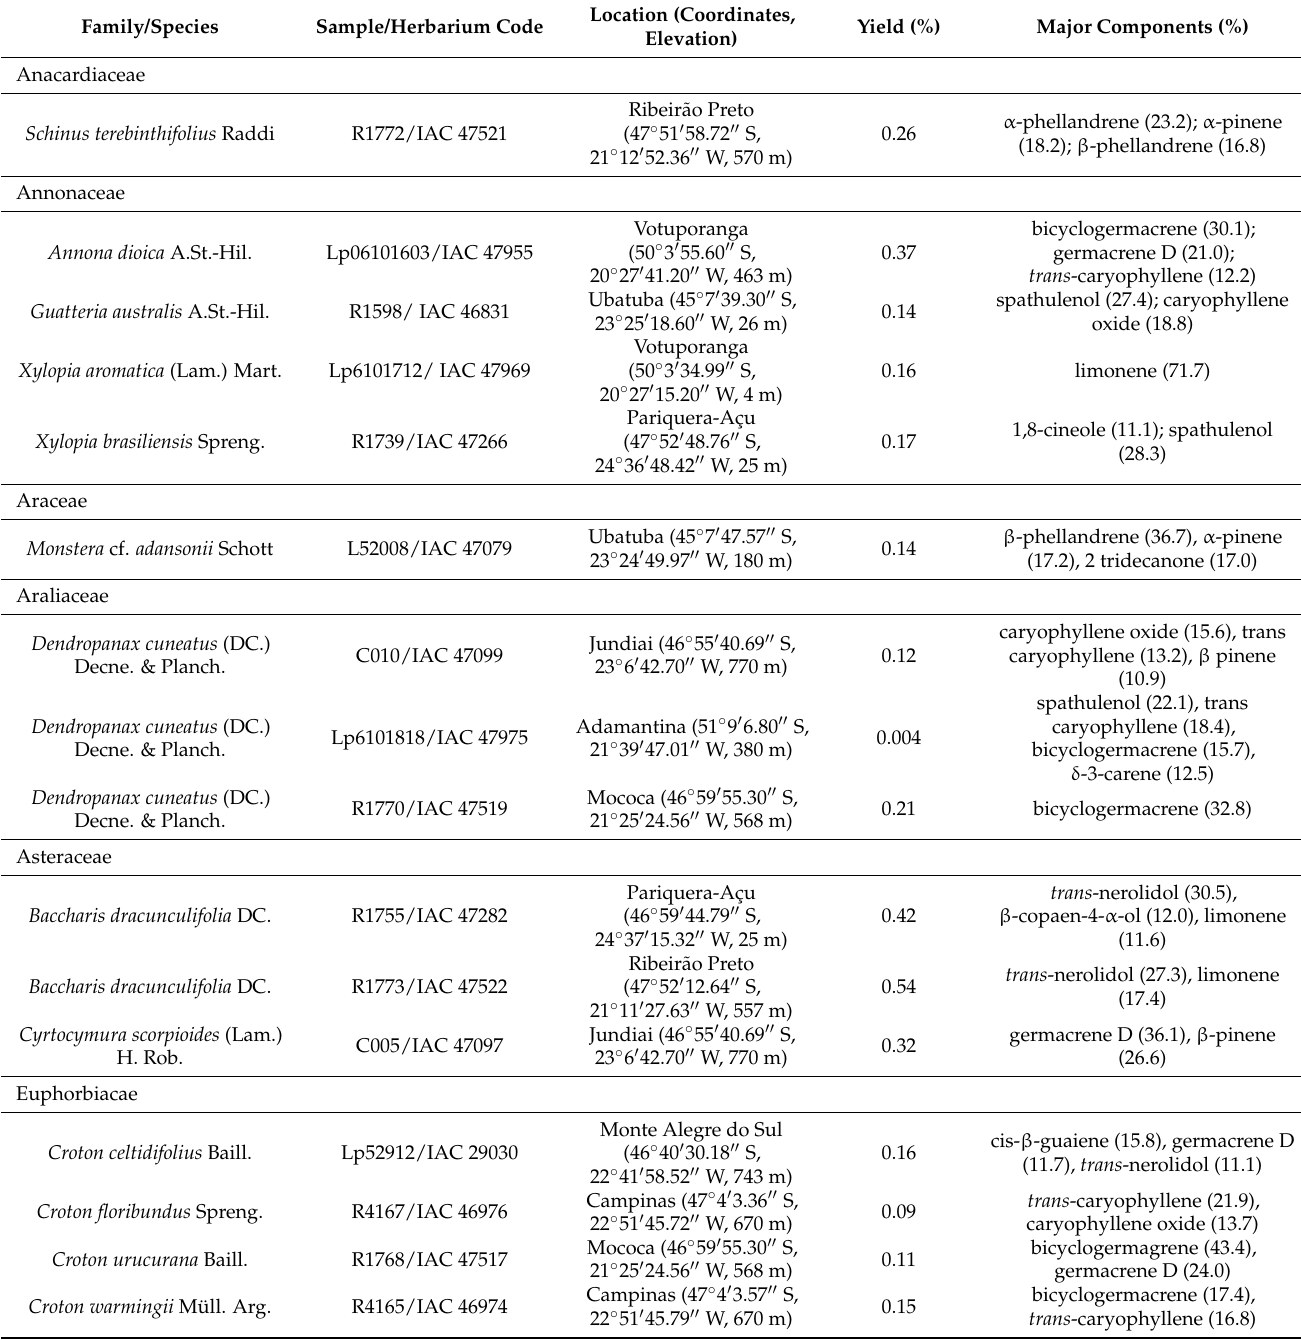
Table 1. Main components ( ≥ 10%) of the essential oil extracted from plant species from the Atlantic rainforest. Plant species are presented within botanical families. Latitude and longitude coordinates are represented as decimal values. Essential oil yield is presented as dry weight ( w / w ) percentages. Complete chemical profile, literature, and calculated retention indices (RI) and experiment metadata are deposited at the National Metabolomics Repository under identifier